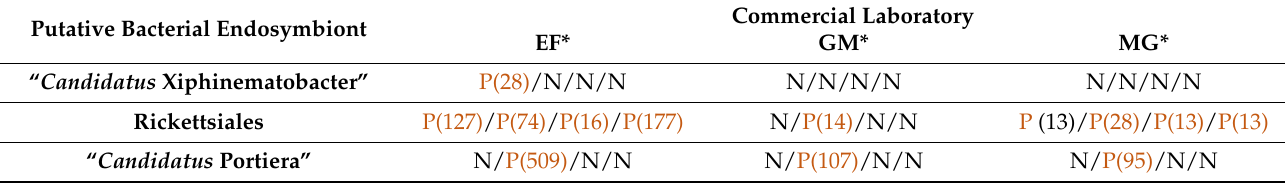
Table 6. Putative bacterial endosymbiont. Abbreviations: N—not available; P—present (number of sequences